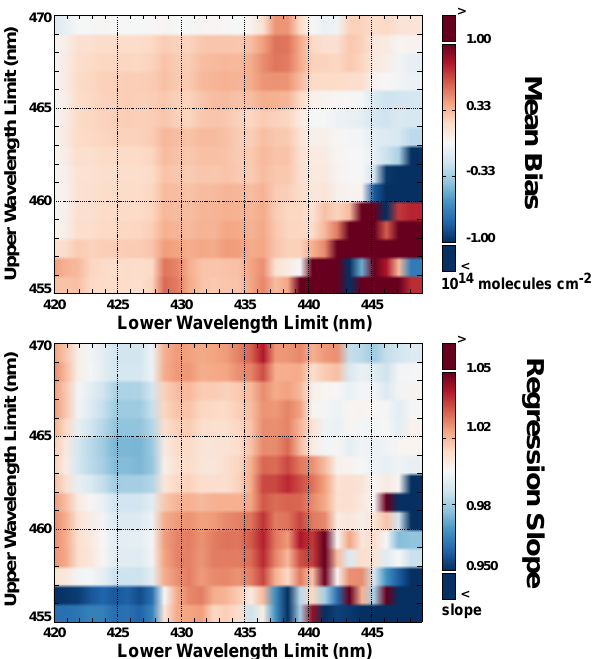
Figure 5. Sensitivity of glyoxal retrieval error to choice of fitting window. Results are from the OSSE described in the text. The top panel shows the mean bias between retrieved glyoxal columns and the true values. The bottom panel shows the slope of the linear re- gression of retrieved vs. true glyoxal columns.